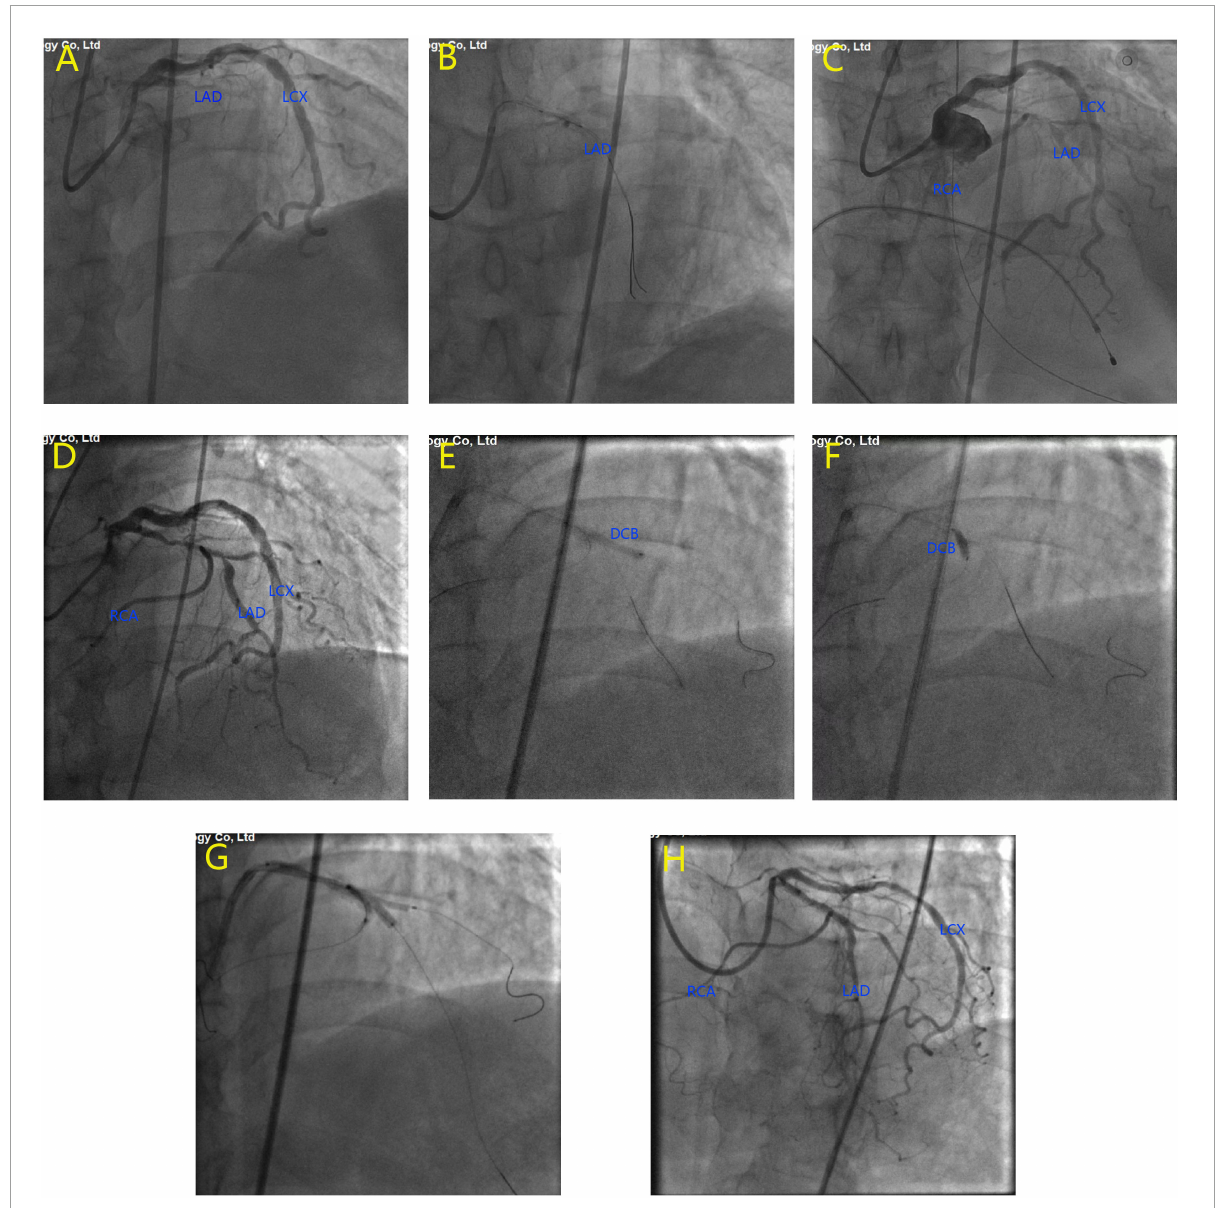
FIGURE2 Emergency coronary angiography at the onset of acute myocardial infarction. The results showed that the proximal left anterior descending artery (LAD) was completely occluded (A) . Balloon dilatation was performed on the occlusive site (B) . TIMI grade 3 flow was restored in LAD and right coronary artery (RCA) (C) . The second coronary angiography at 4 months after myocardial infarction. The results showed high-grade lesion at the proximal LAD, as well as at LAD/RCA bifurcation and LAD/diagonal bifurcation (D) . Drug-eluting balloons were used to dilate the diagonal branch (E) and the RCA (F) . A drug-eluting stent in LAD and 2 balloons in D1 and RCA were dilated simultaneously for kissing balloon inflation (G) . Final imaging results after procedure (H)